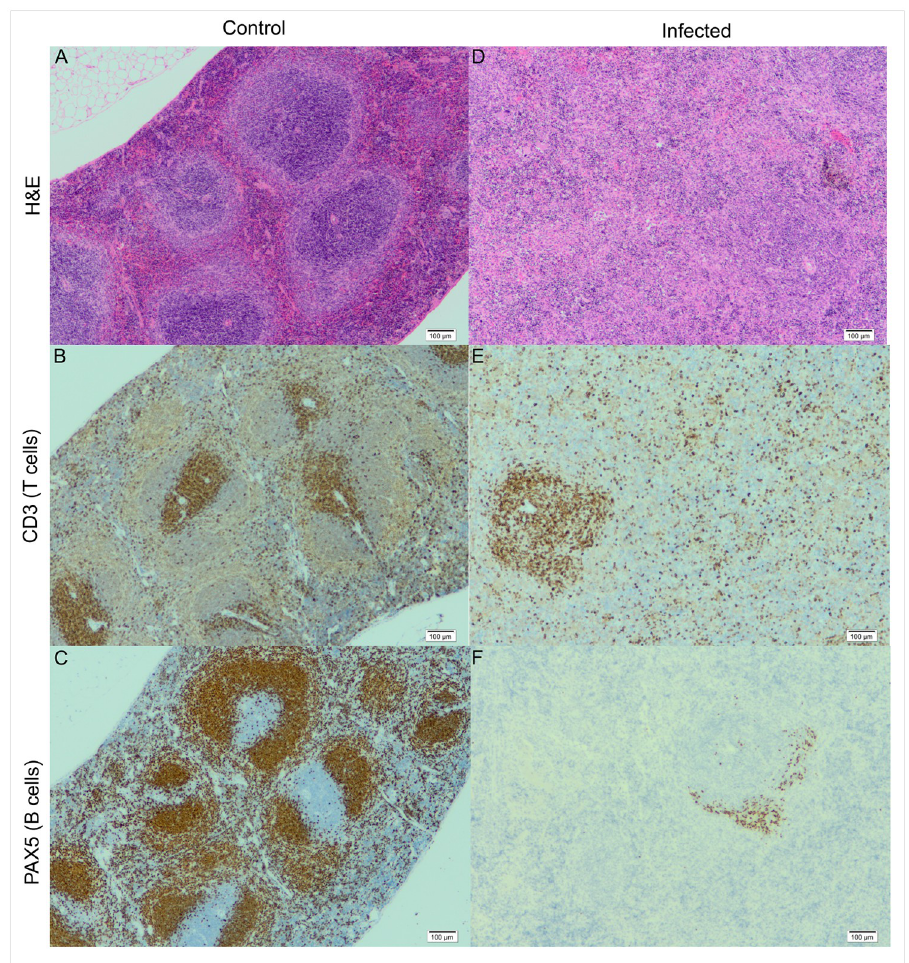
Fig 5. Histology of the infected and control spleen. Three stains (H&E, CD3 [T cell marker] and Pax5 [B cell marker]) were used to examine infected spleens (right) and uninfected spleens from the control group (left). A breakdown in the distinction between the red and white pulp can be seen in the infected group (D) compared to spleens from uninfected animals (A). The T cells are more diffuse in the spleen (C & D), with almost a complete loss of B cells for the infected mice (E & F). Images taken using x40